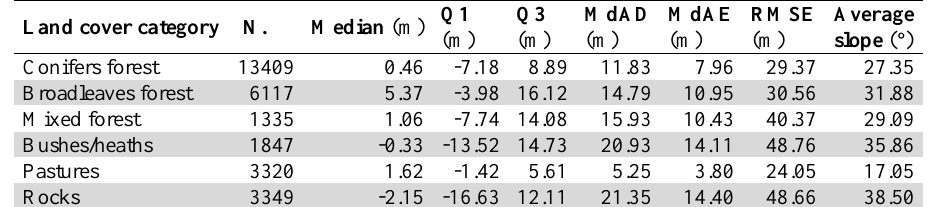
Land cover category N.